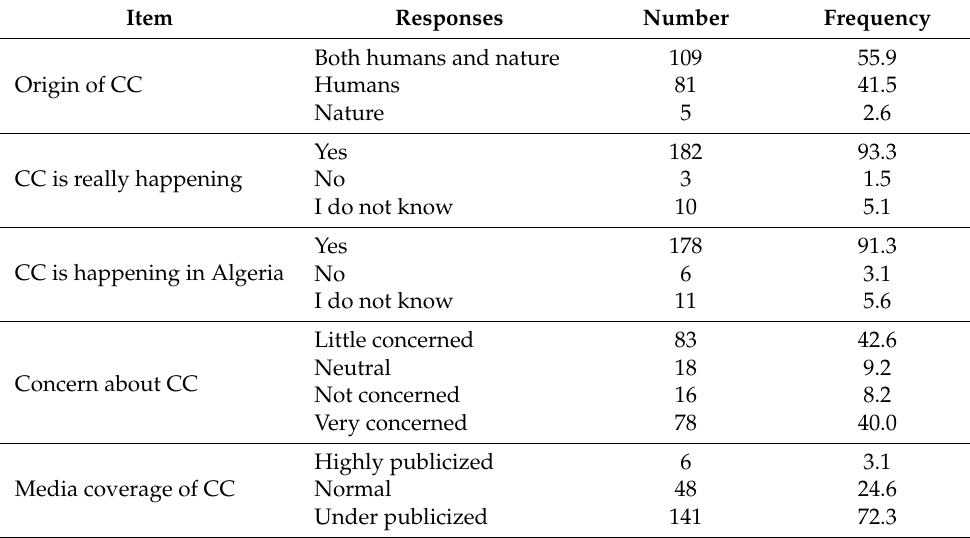
Table 2. Perception and concern about